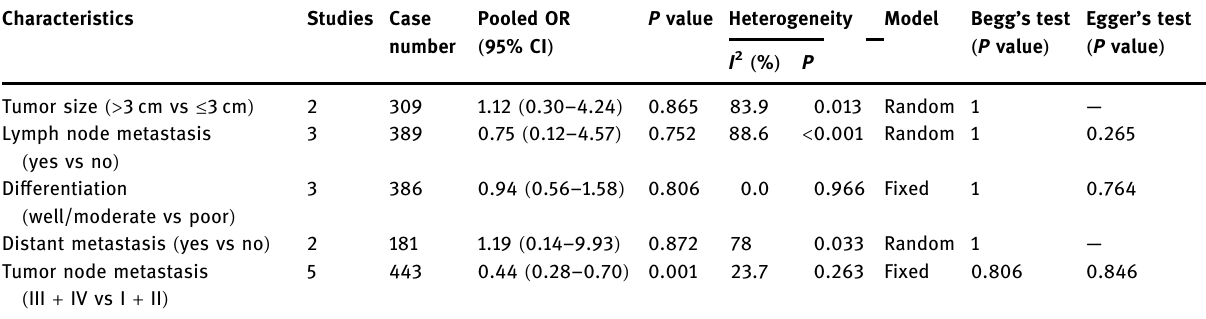
Table 2: The relationship between SIRT6 expression and clinicopathological characteristics Characteristics